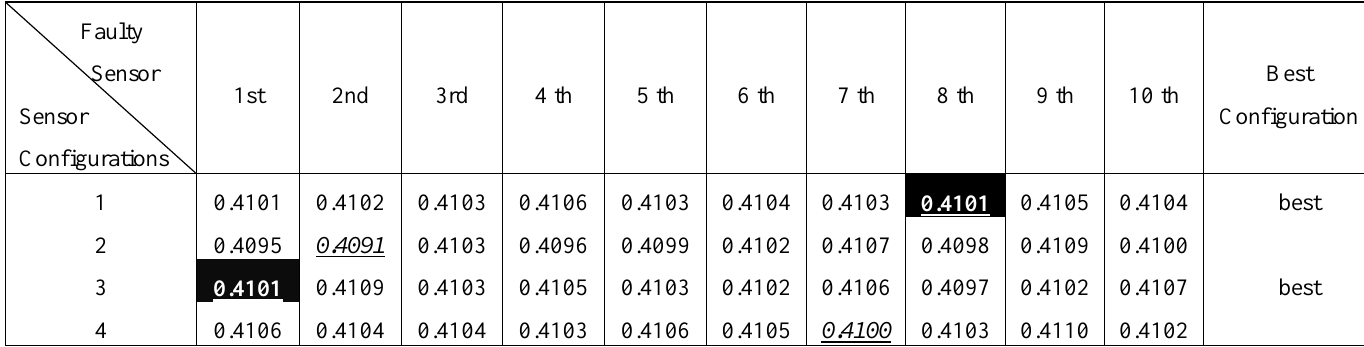
Table 11 . PCI for each faulty sensor with